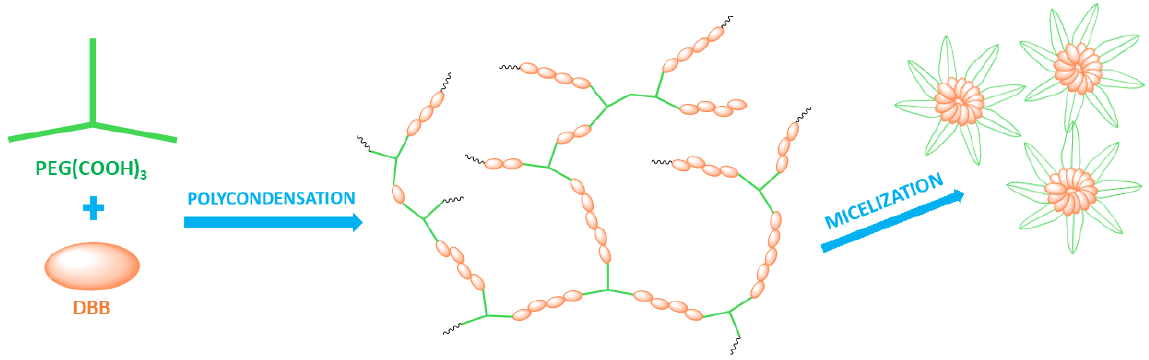
Figure 1. Scheme presenting the stages of the research.